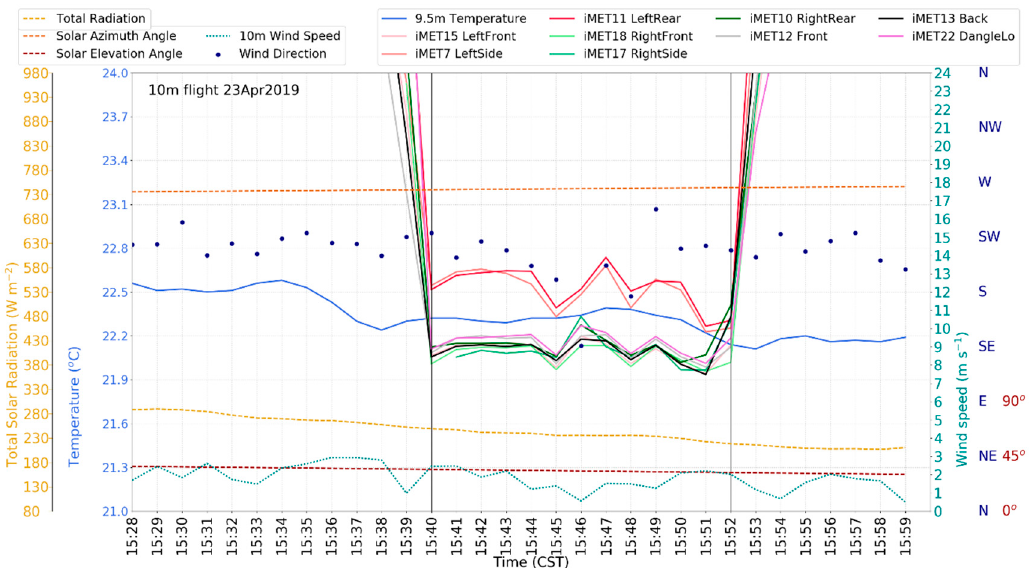
Figure 11. Time series from the 23 April 2019 of the tower temperature at 9.5 m (°C, solid blue), iMET-XQ temperatures (°C, various solid colors as shown in the legend), solar radiation (W m − 2 , dashed mustard yellow), solar azimuth angle (degrees, dashed orange), solar elevation angle (degrees, dashed brown), tower wind speed at 10 m (m s − 1 , dotted green), and the tower wind direction at 10 m (degrees, dark blue dots). The two vertical black lines indicate the start and end times of the 10 m flight.